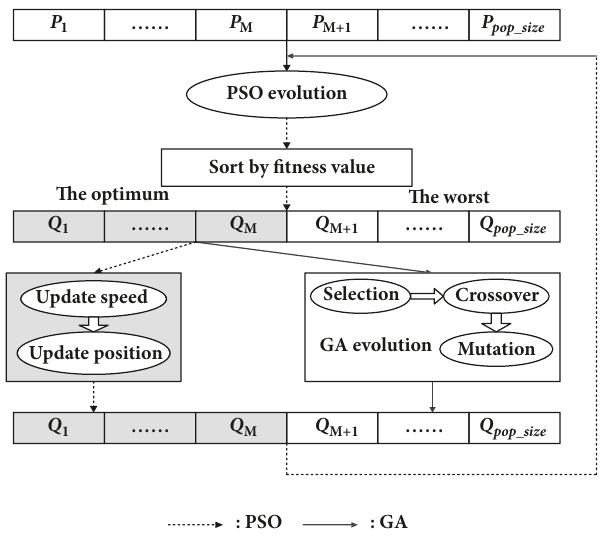
Figure 1: GA-PSO hybrid optimization